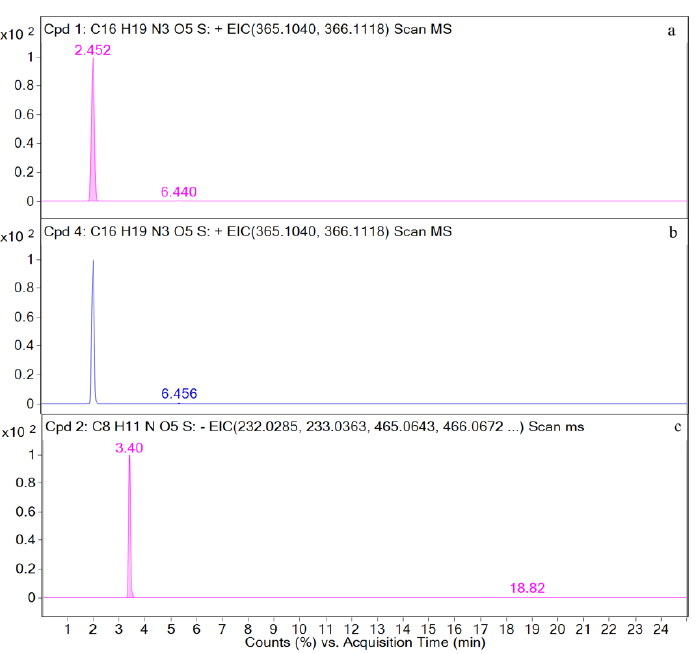
Figure 10. Ion chromatograms of plasma samples. ( a ) M1; ( b ) M3; ( c ) M4. M1, M3, and M4 are detected in the liver sample. The EIC and TIC for the liver sample are shown in Figure 11 and Figure A4 in the Appendix A, respectively.